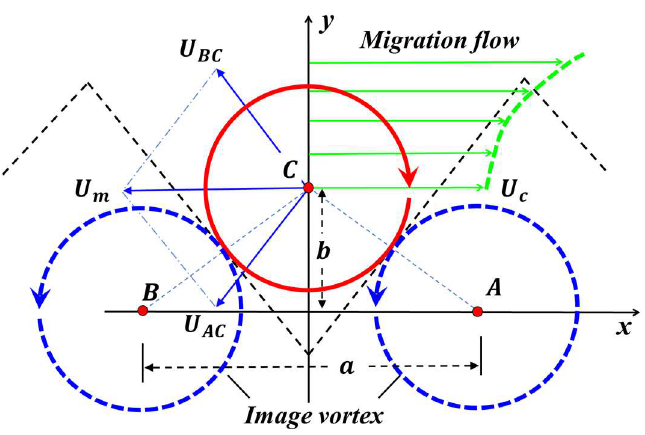
Figure 3. Vorticity kinematics conditions for stabilizing boundary vortices.